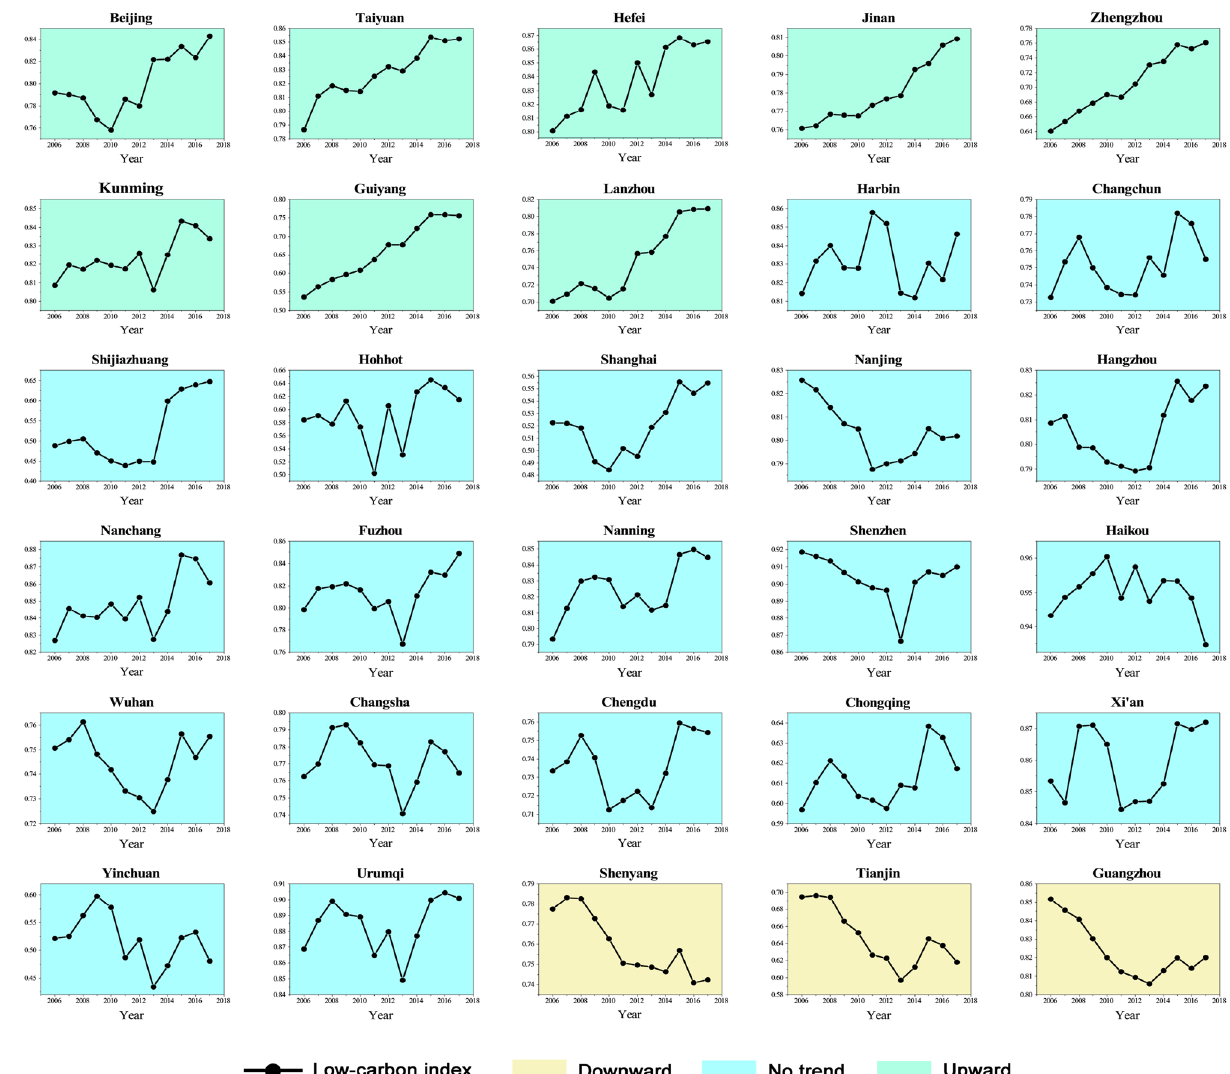
Figure 3. Trend of the low-carbon index in typical cities in